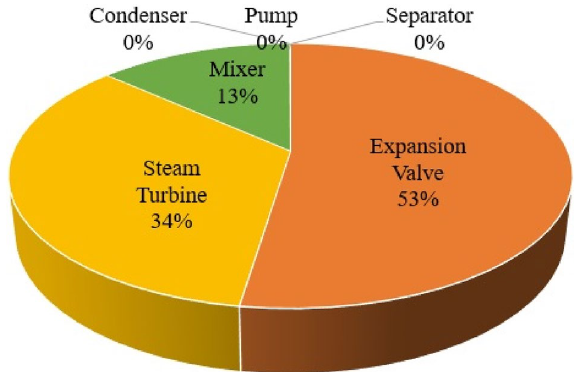
Fig. 3 Pie chart of exergy destruction rates of